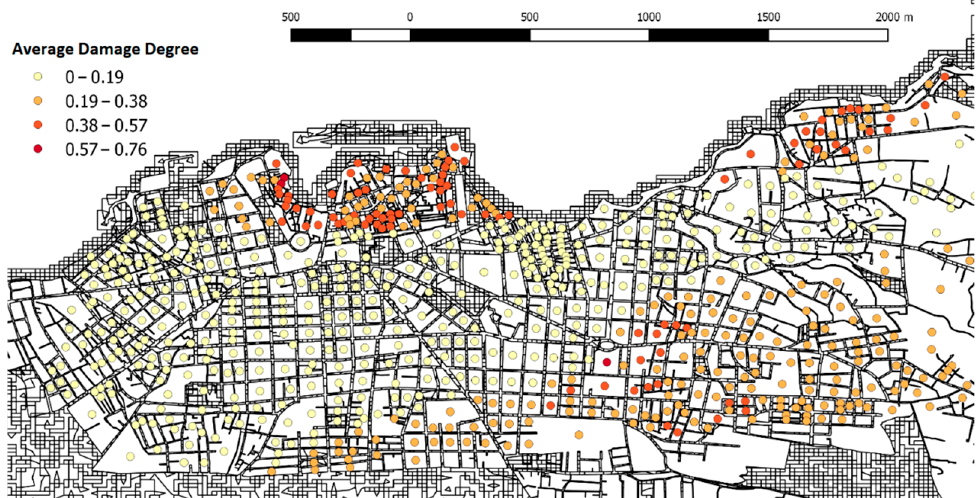
Figure 9. Average degree of damage for the external seismic model based on the Gavdos earth- quake, 2012.